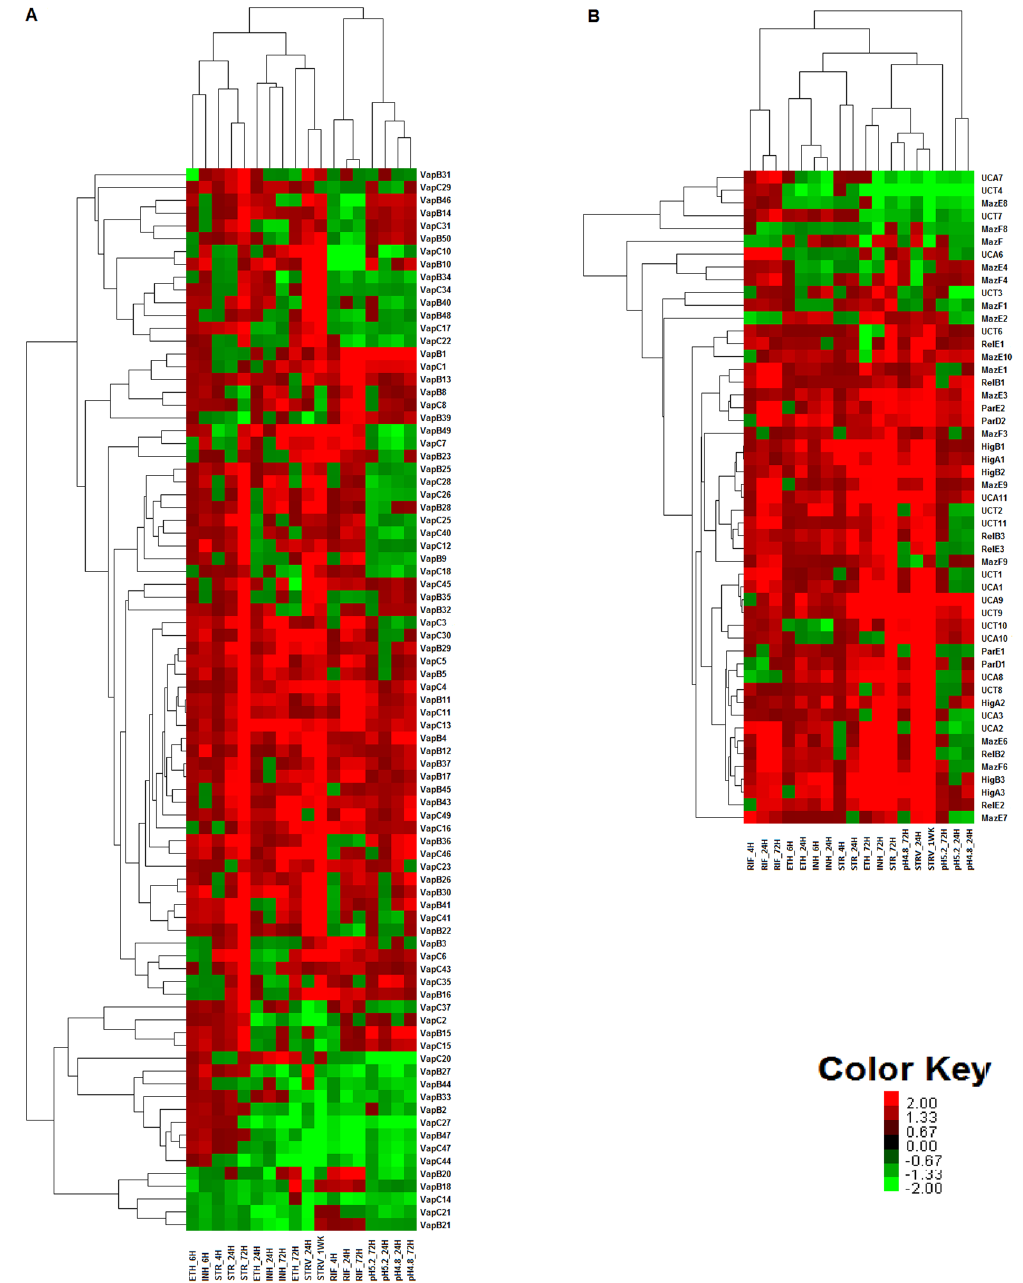
Figure 4. Unsupervised hierarchical clustering analysis of Differentially expressed TA Loci TA genes 1.5 fold up and down regulated along with their fold change were subjected to unsupervised hierarchical clustering. Up regulated genes are in red color gradient and down regulated genes are in green colour gradient. Fold change of 2 was given as a cutoff to render the cluster image to identify patterns of up and down regulated